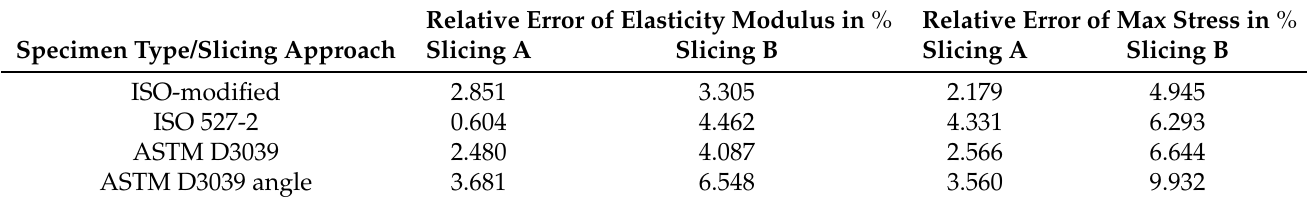
Table 8. Relative errors of elasticity modulus and max stress.